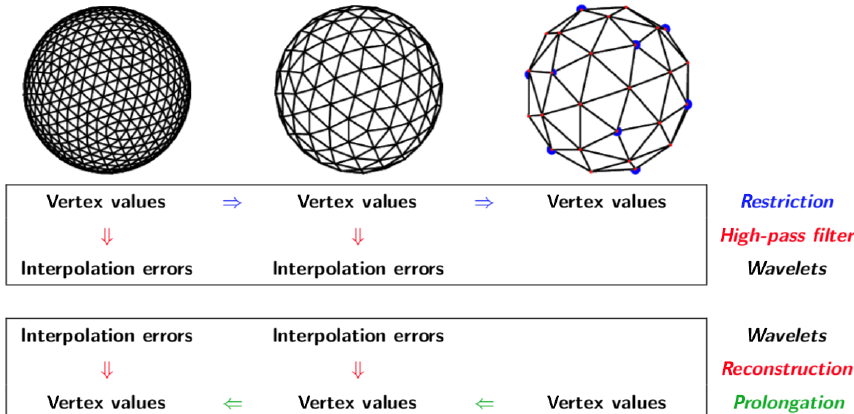
Figure 2. Wavelet transform on a non-adaptive icosahedral grid with three scales.